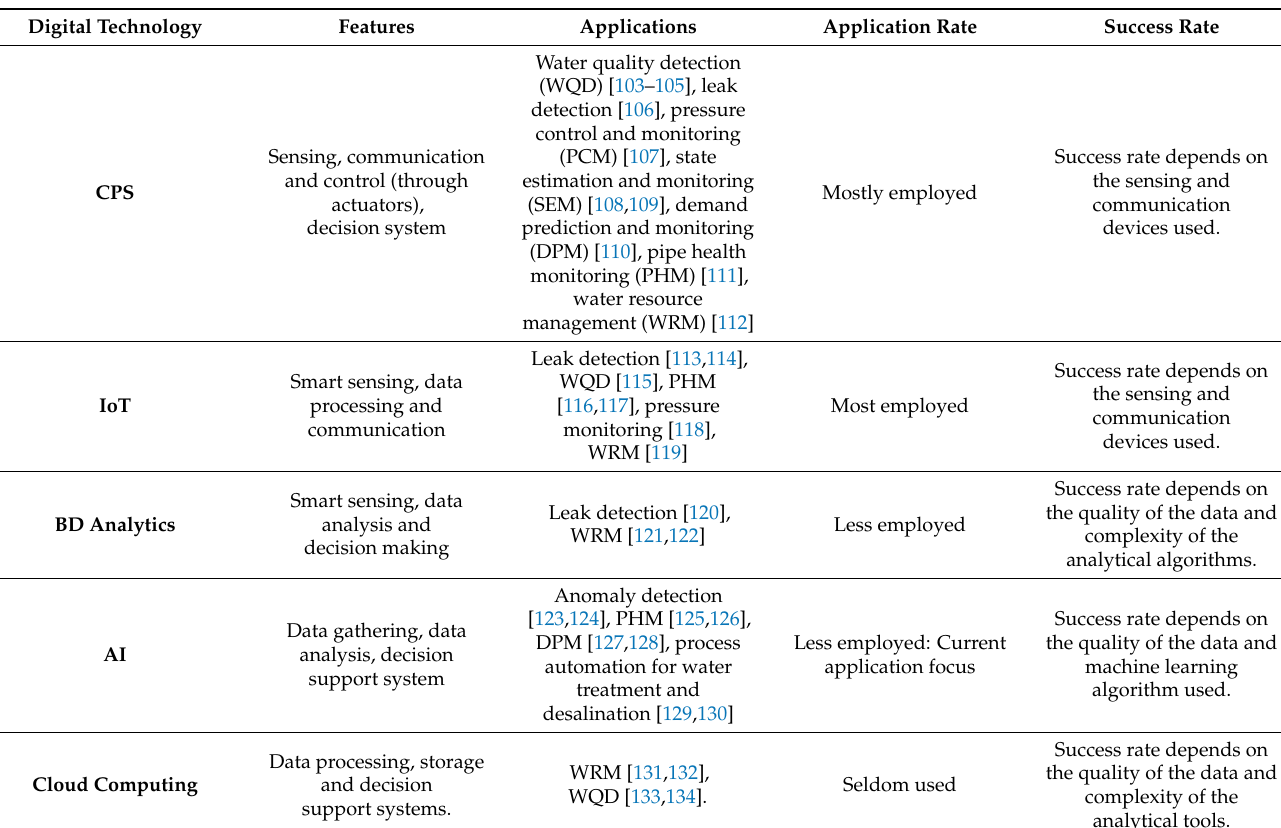
Table 3. Comparison of the key drivers of Water